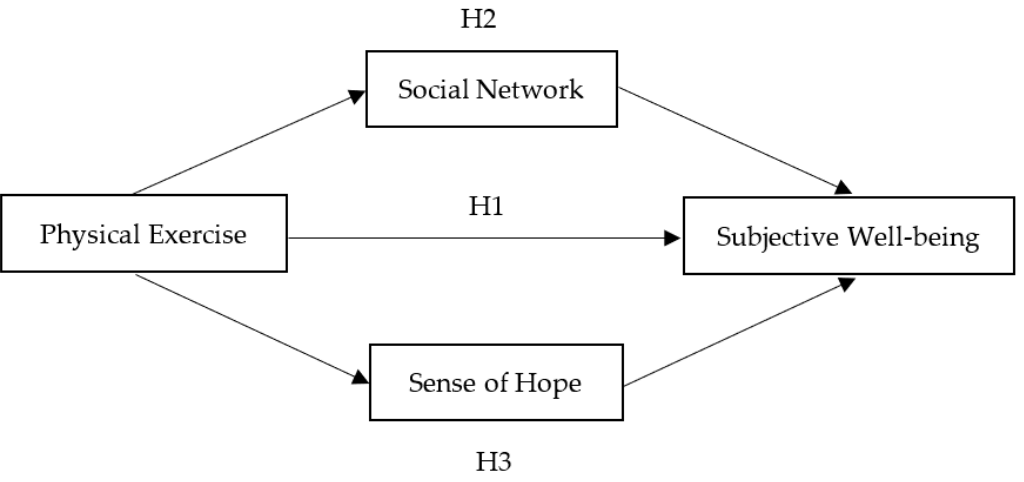
Figure 1. The parallel ‐ mediation model.